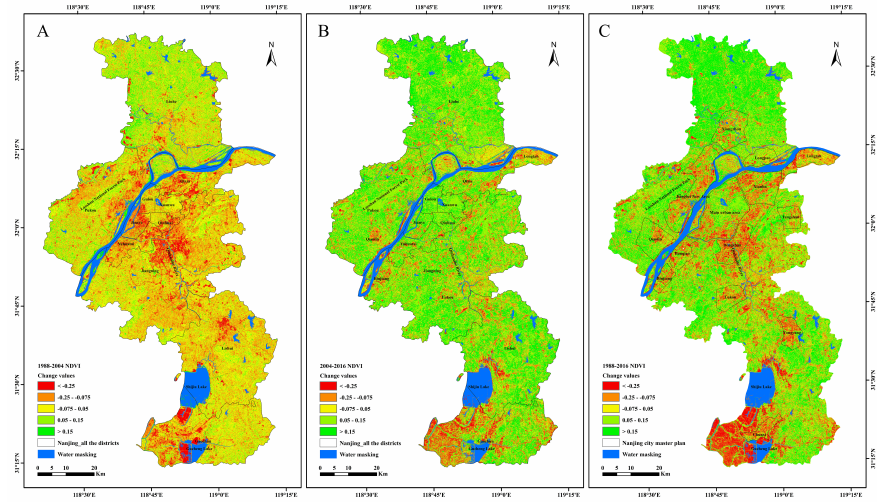
Figure 5. Spatial distribution of the normalized di ff erence vegetable index (NDVI) change in Nanjing with the minimal surface water as the masking in the period 1987–2017: ( A ) NDVI change during the period from 1988 to 2004, ( B ) NDVI change during the period 2004–2017, and ( C ) NDVI change during the period from 1988 to